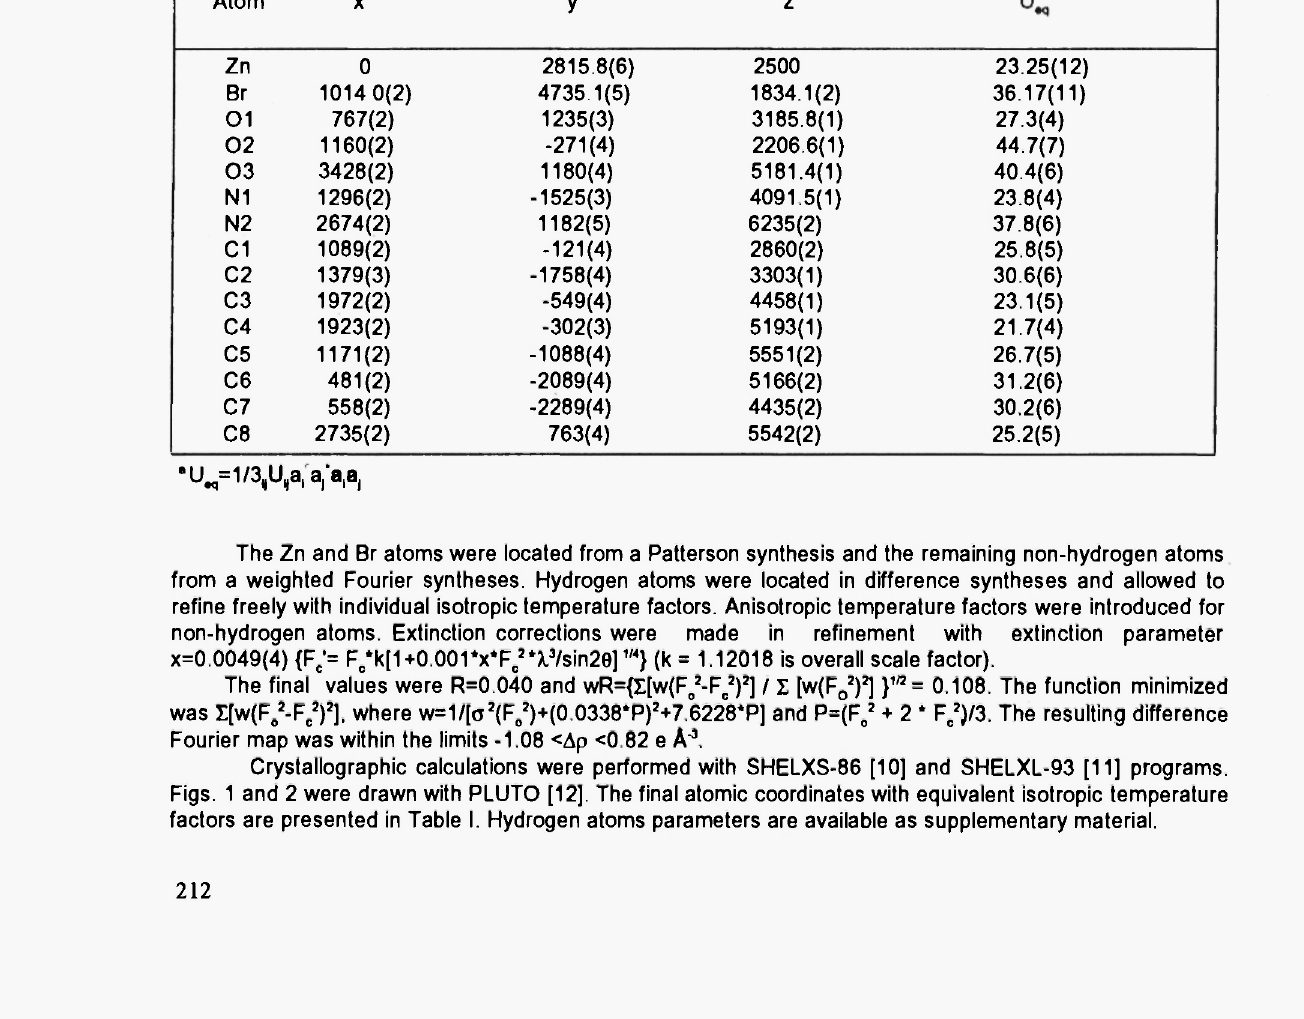
Table I. Atomic positional parameters (x10 4 ) with equivalent isotropic temperature factors" (A 2 x10 3 )